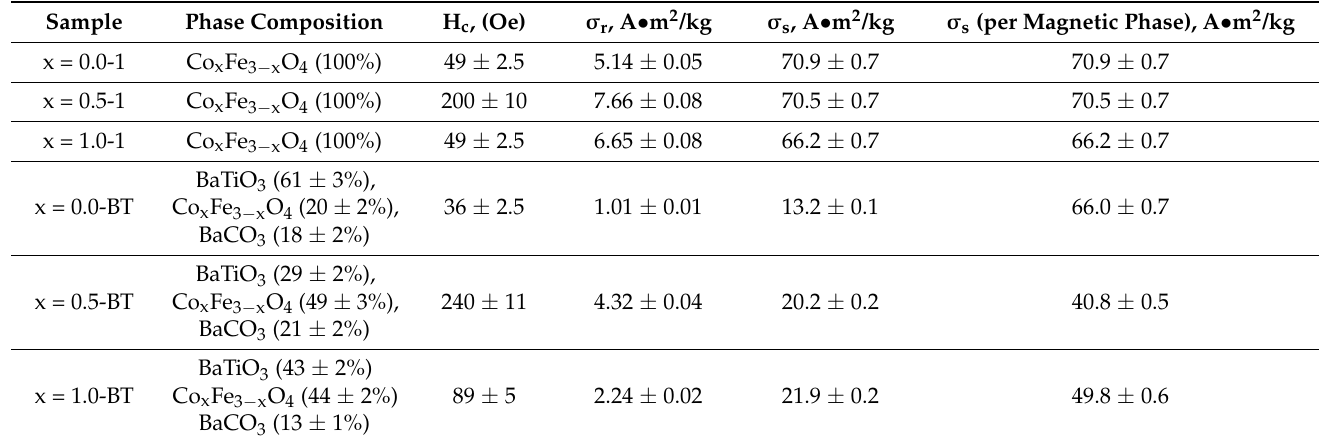
Table 2. VSM data for the synthesized samples.